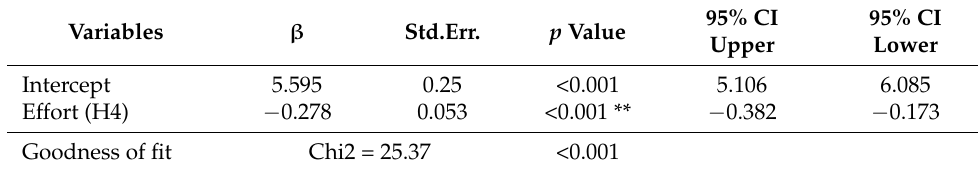
Table 5. Effect of perceived mental effort on satisfaction. Variables β